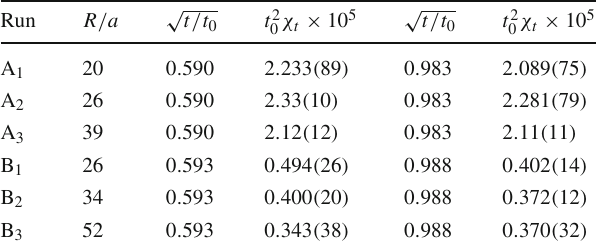
Fig. 3 Valuesof χ t ( R ) obtainedonthe A 3 latticeattwoflowtimescor- responding to smoothing ranges equal to 0 . 28fm (squares) and 0 . 47fm (diamonds) Table 3 Simulation results for χ t